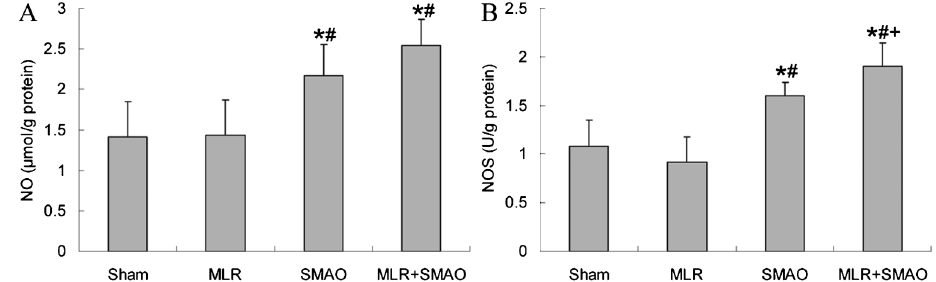
Figure 3. Effect of mesenteric lymph reperfusion (MLR) on the nitric oxide (NO) level and nitric oxide synthase (NOS) activity in splenic homogenate of rats with superior mesenteric artery occlusion (SMAO) shock. Data are reported as means±SD, n=6. A , NO level. B , NOS activity. *P , 0.05 vs sham group; # P , 0.05 vs MLR group; + P , 0.05 vs SMAO group (one-way